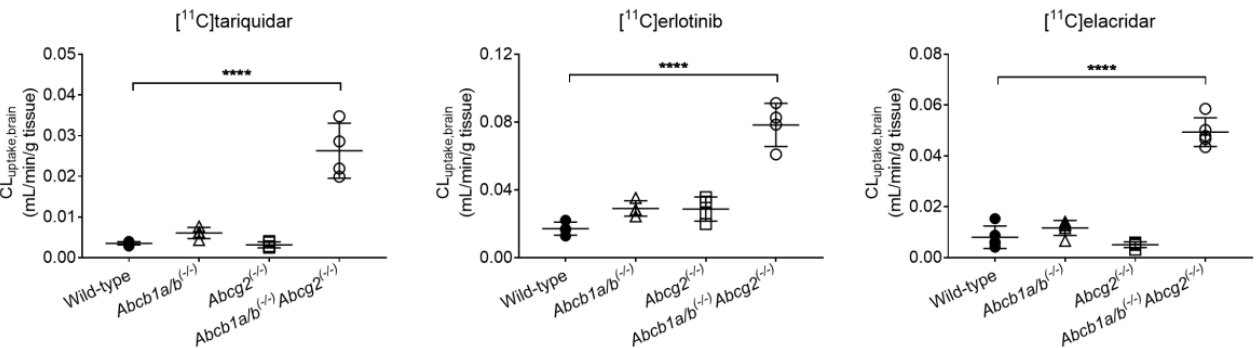
Figure 3. Initial brain uptake clearance (CL uptake,brain ) of [ 11 C]tariquidar, [ 11 C]erlotinib, and [ 11 C]elacridar determined with integration plot analysis in wild-type, Abcb1a/b ( − / − ) , Abcg2 ( − / − ) , and Abcb1a/b ( − / − ) Abcg2 ( − / − ) mice. **** p ≤ 0.0001, one-way ANOVA followed by a Dunnett’s multiple comparison test against the reference group (wild-type). Table 1. PK parameters obtained with graphical non-compartmental analysis describing the brain distribution of [ 11 C]tariquidar, [ 11 C]erlotinib, and [ 11 C]elacridar in wild-type, Abcb1a/b (-/-) , Abcg2 (-/-) , and Abcb1a/b (-/-) Abcg2 (-/-) mice.